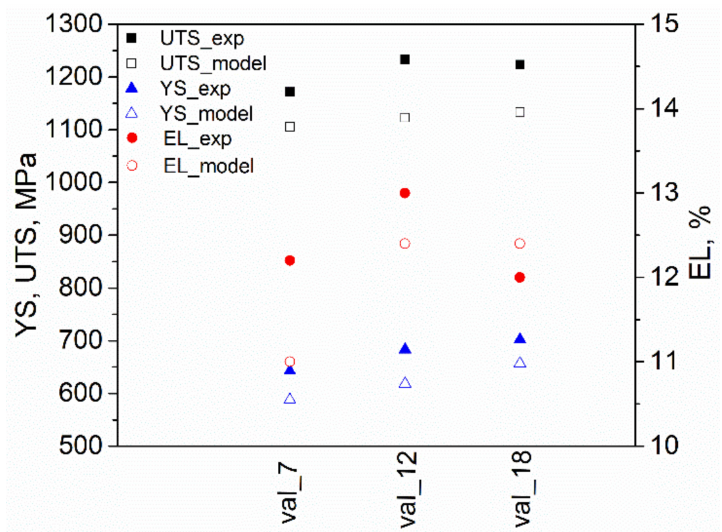
Figure 7. Comparison of predicted and experimental mechanical